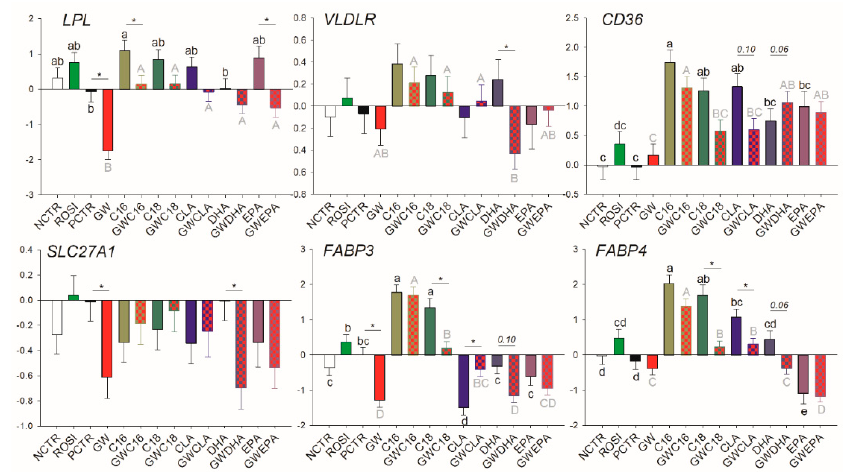
Figure 2. Effect of LCFA (palmitic acid [C16], stearic acid [C18], trans10, cis12 conjugated linoleic acid [CLA], docosahexaenoic acid [DHA], and eicosapentaenoic acid [EPA]), PPAR γ agonist (ROSI; rosiglitazone) and LCFA + PPAR γ antagonist (GW; GW9662) on transcription of genes involved in LCFA transport. Lower case letters and uppercase letters denote statistical differences ( p < 0.05) between treatments without GW and treatments with GW, respectively. * denotes statistical difference ( p < 0.05) between presence and absence of GW in the same LCFA treatment. For GW treatment alone, * denotes statistical difference ( p < 0.05) with the PCTR.